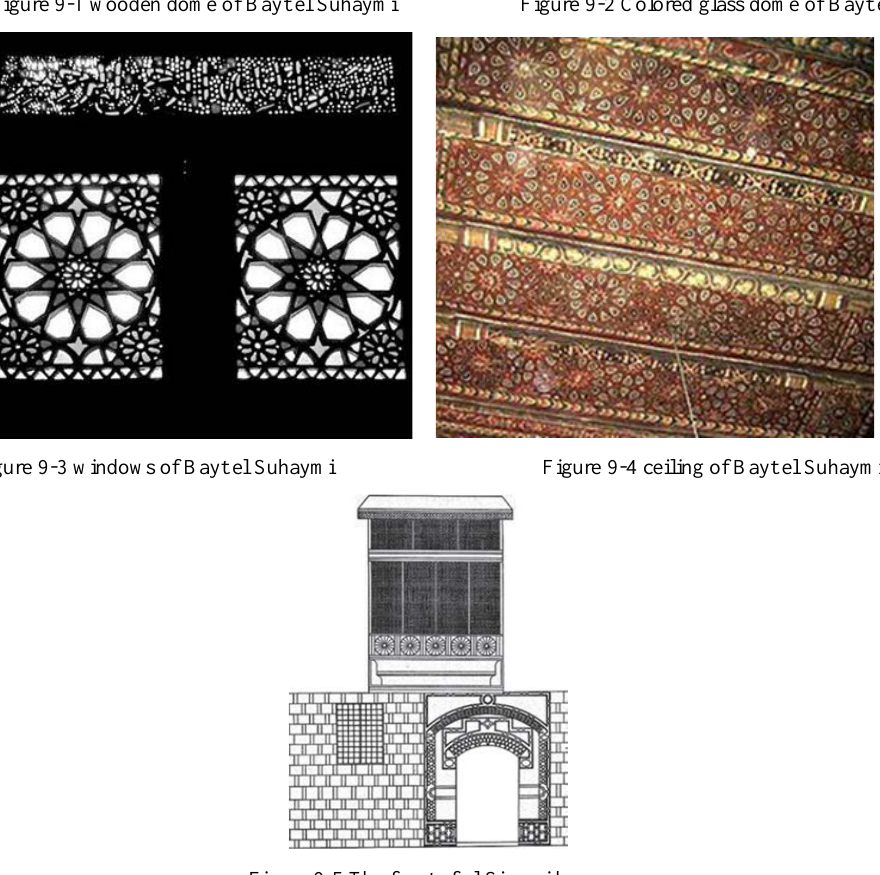
Figure 9-5 The front of al Sinnari